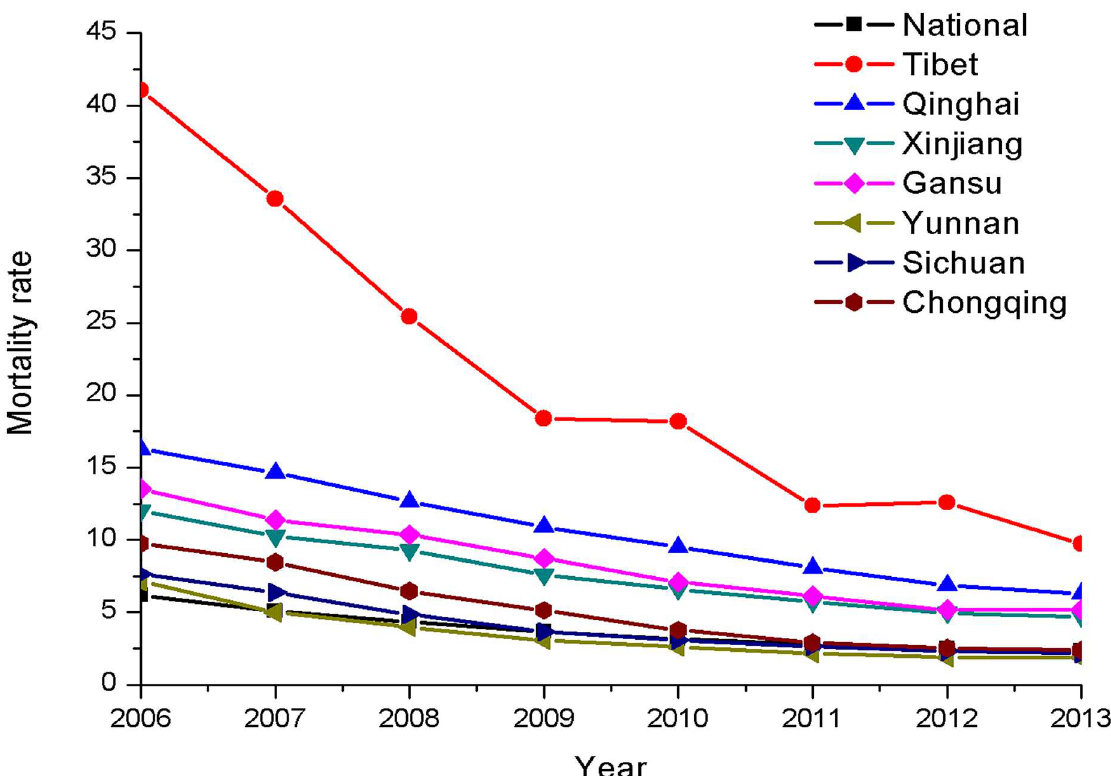
Fig 3. Mortality rate per 10 000 vehicles from 2006to 2013.